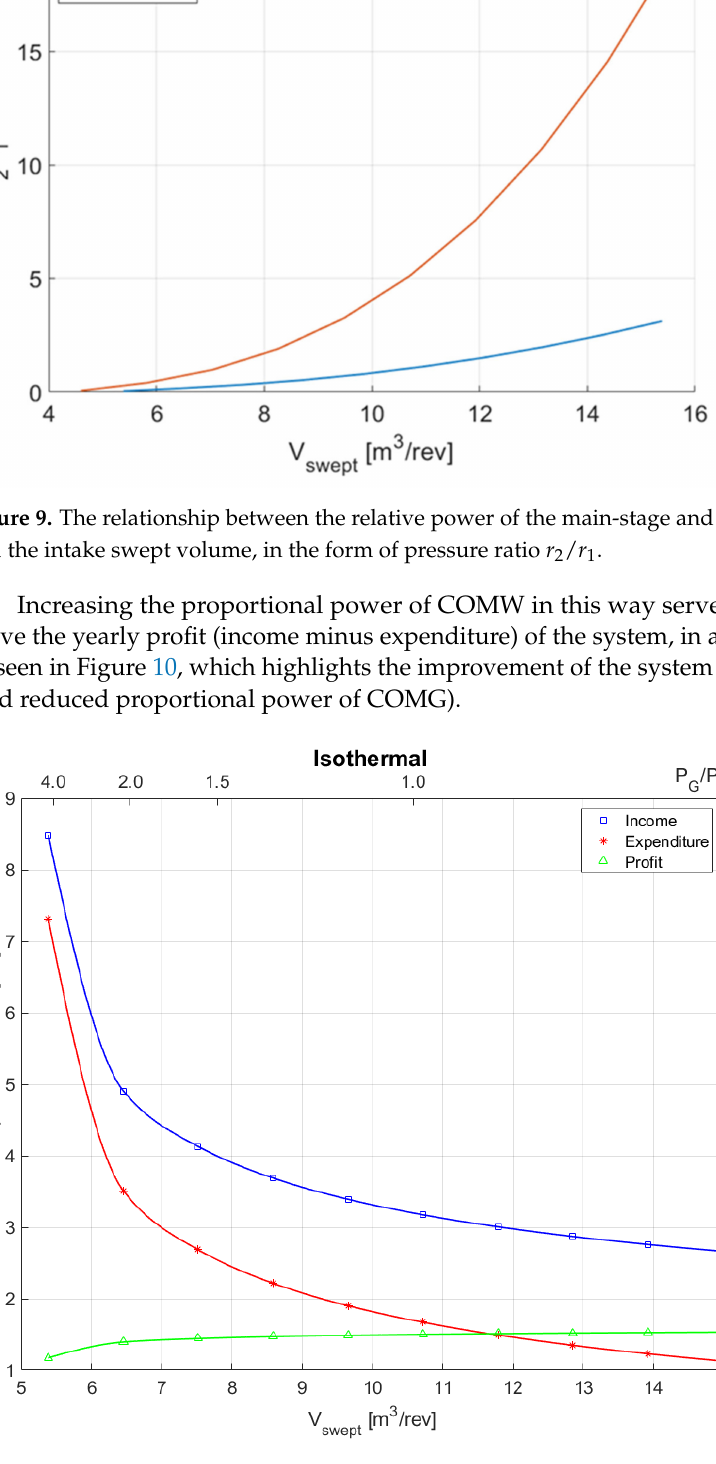
. Figure 10. Income, expenditure and profit for representative isothermal ( above ) and adiabatic ( be- low ) systems with 200 h of storage. Also shown on the upper x-axes is the proportional power of COMG compared with COMW. Decreasing this ratio improves financial performance. While the income of the system is reduced by increasing V swept —a function of the total system power reducing as the proportional power of COMW, which is set at 8 MW, in- creases—the expenditure of the system decreases more quickly, resulting in greater profit. The expenditure is further reduced in the adiabatic case compared with the isothermal